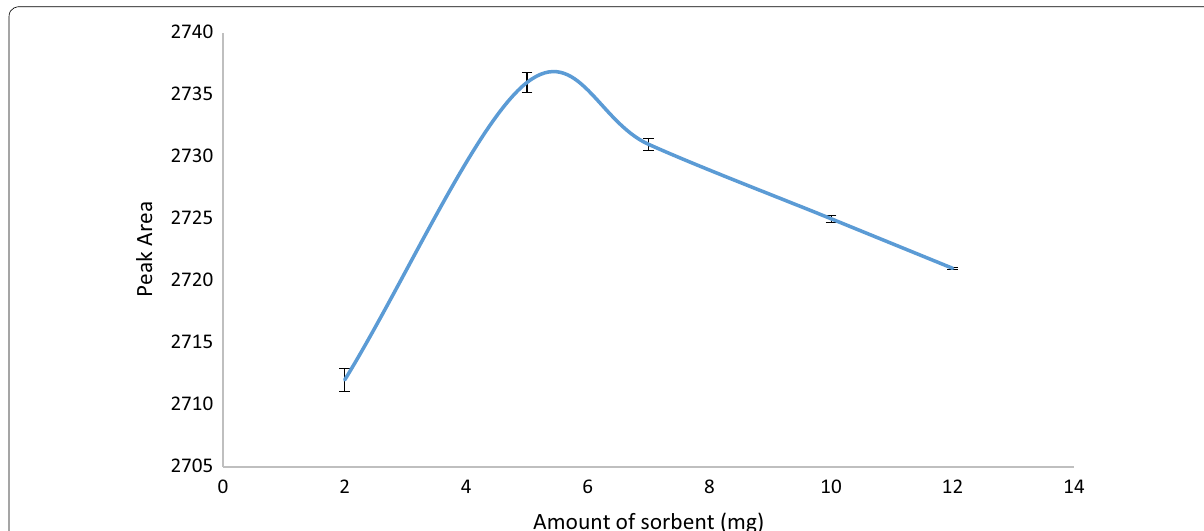
Fig. 7 Effect of amount of sorbent on extraction efficiency of CBZ (Experimental conditions: pH: 7.5; sample volume: 150 µL; volume of eluent: 30 µL and number of draw/eject cycle for sample solution and eluent: 10 cycles)